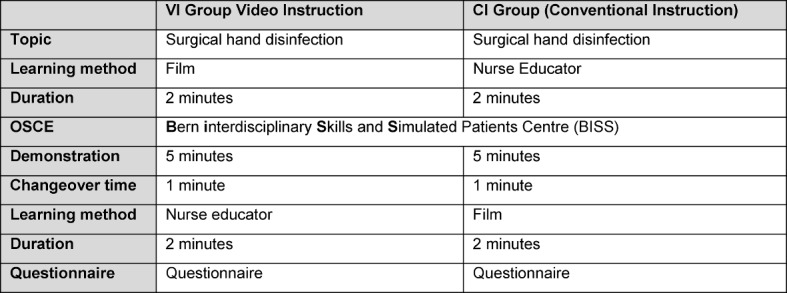
Process Schedule